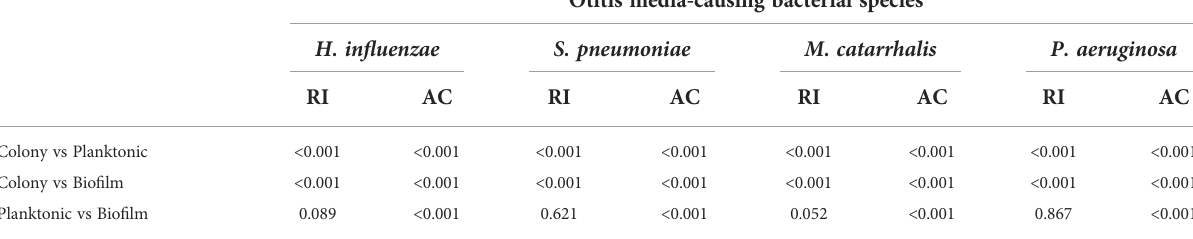
TABLE 4 Inter-group comparison of p-values among bacterial species in colony, planktonic, and bio fi lm forms by one-way ANOVA with post-hoc Tukey ’ s HSD test.